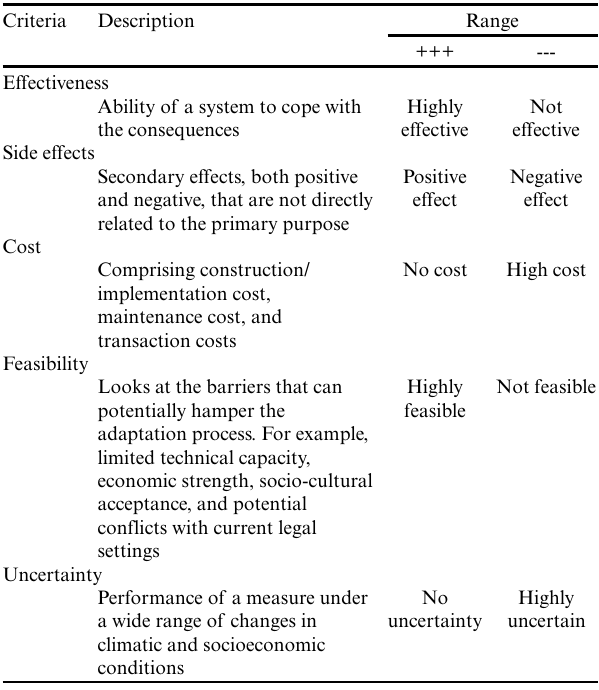
Table 2 . Description with score card for the selected criteria of multicriteria